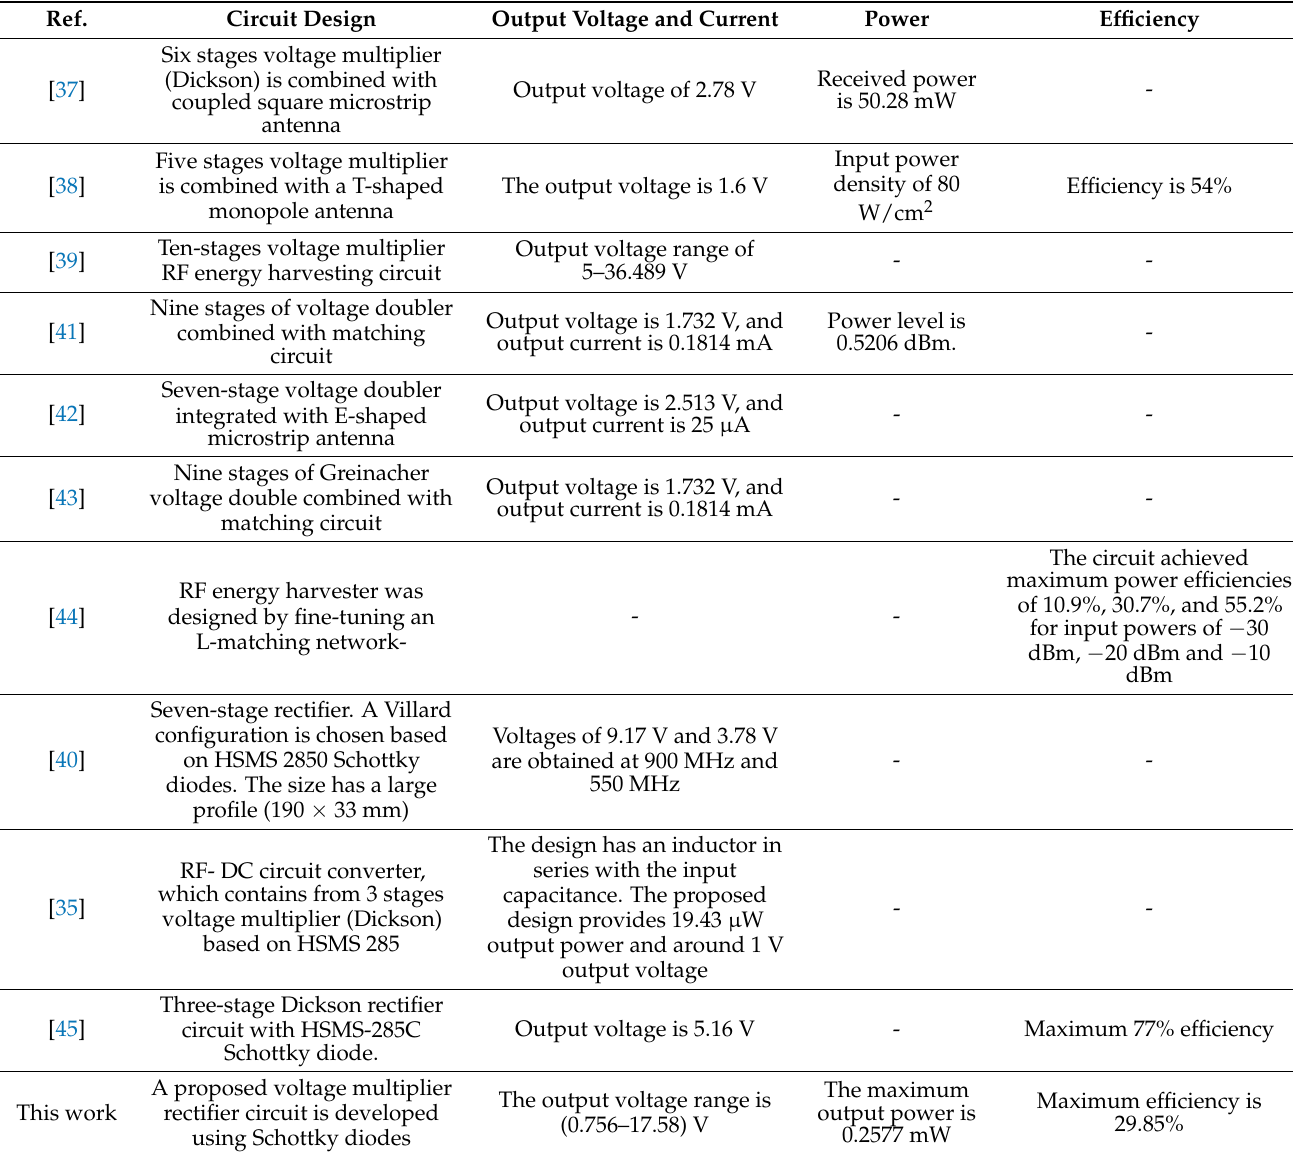
Table 4. Comparison of related project’s